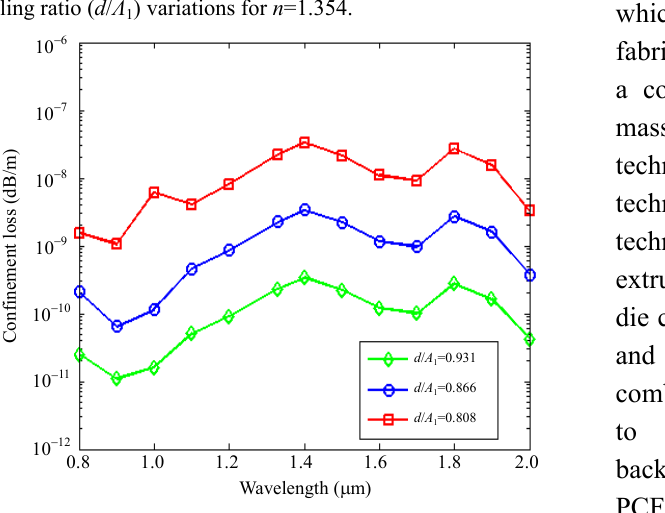
Fig.8 Comparison of confinement loss with cladding air filling ratio ( d / Ʌ 1 ) variations for n = 1.354.